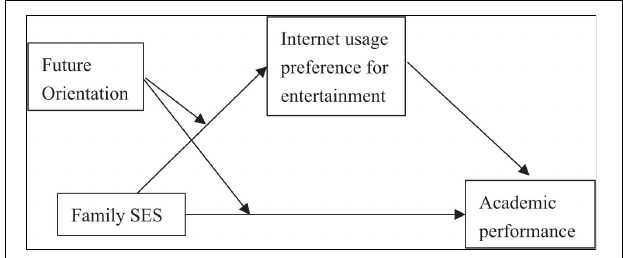
FIGURE 1 | A hypothesized moderated mediation